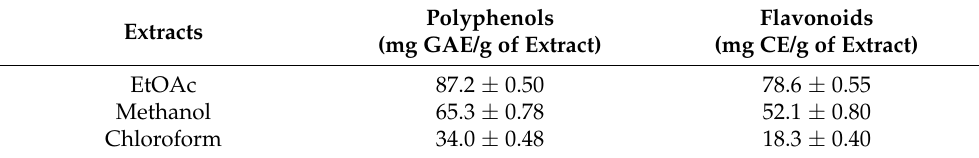
Table 1. TPC and TFC of I. viscosa leaves extracts. Data are expressed as mean ± SD ( n = 3).